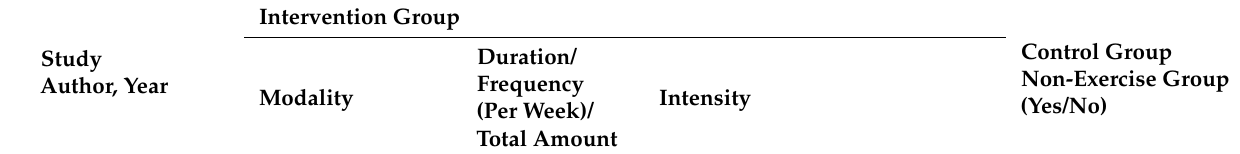
Table 3. The characteristics of the control groups in the studies under